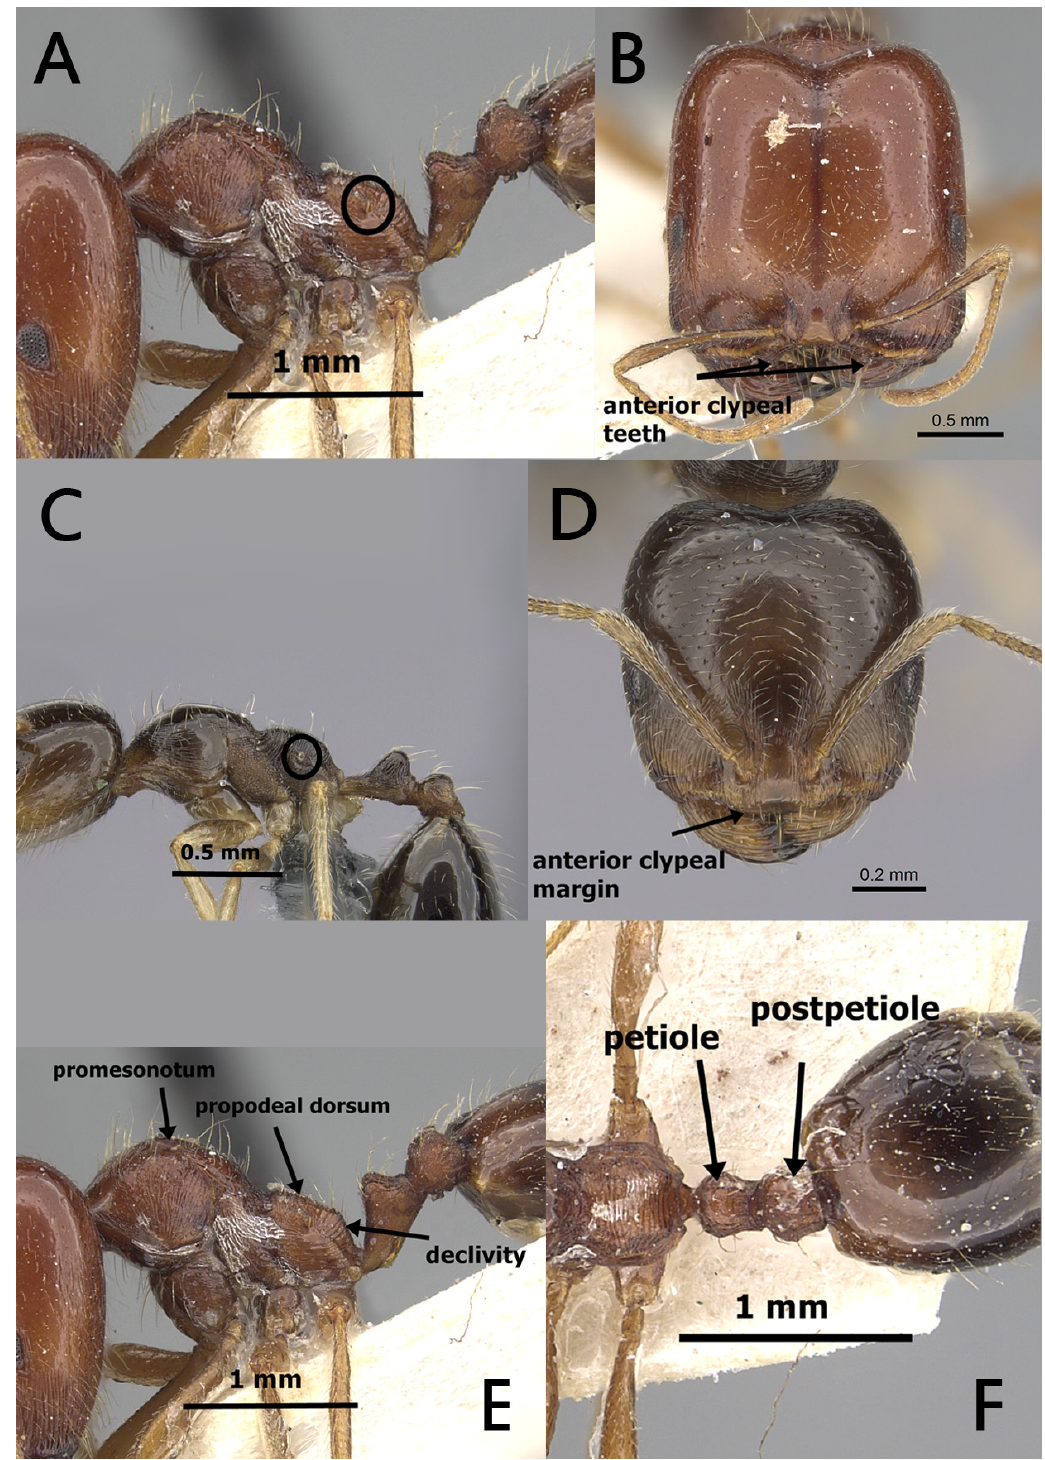
Fig. 2. A . Vertical propodeal spiracle of Trichomyrmex abyssinicus (Forel, 1894a). B . Head of T. abyssinicus in full-face view showing clypeus and mandibles. C . Circular propodeal spiracle of T. mayri (Forel, 1902) . D . Head of T. mayri in full-face view showing clypeus. E . Mesosoma of T. abyssinicus in profile. F. Petiole and postpetiole of T. abyssinicus in dorsal